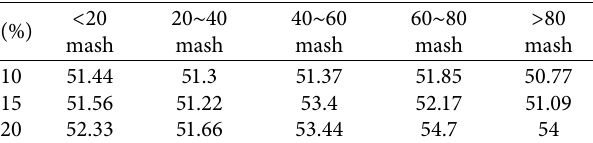
Table 2: The influence of modified asphalt content on the softening point of petroleum